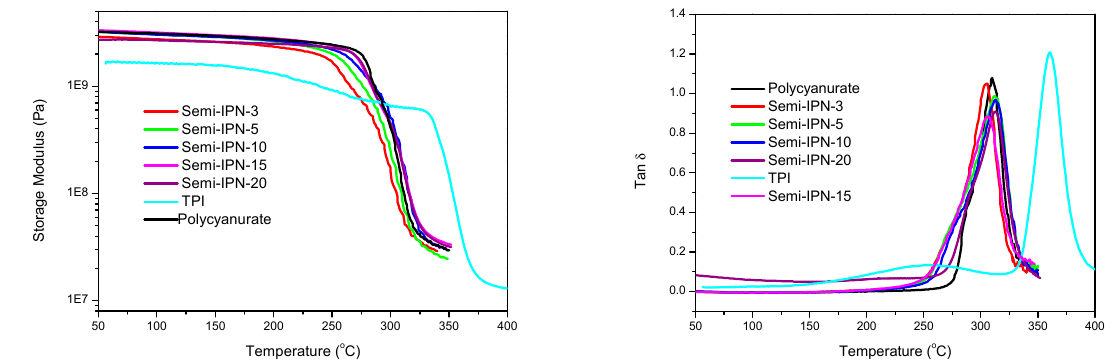
Figure 6. Dynamic mechanical analysis (DMA) results for polycyanurate, TPI, and semi-IPNs (Left: storage modulus versus temperature; Right: tan δ versus temperature).